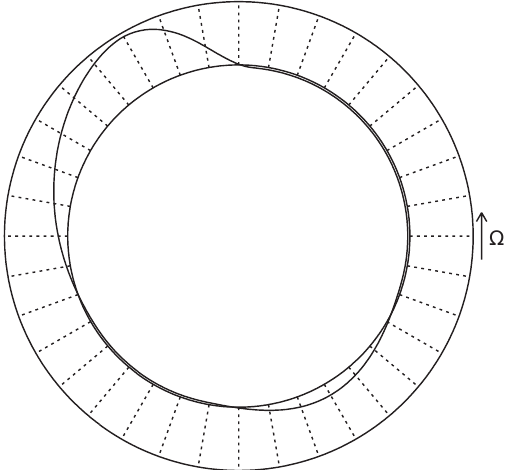
Fig. 3. Polar view corresponding to the flux tube configuration of Fig. 2. Shown is a projection of the tube on the equatorial plane. Note the distinct geometric asymmetry between the two legs of the emerging loop. Since the unstable mode has an azimuthal wave number m = 2, a second loop can be seen emerging at about 180 (cid:14) longitude distance from